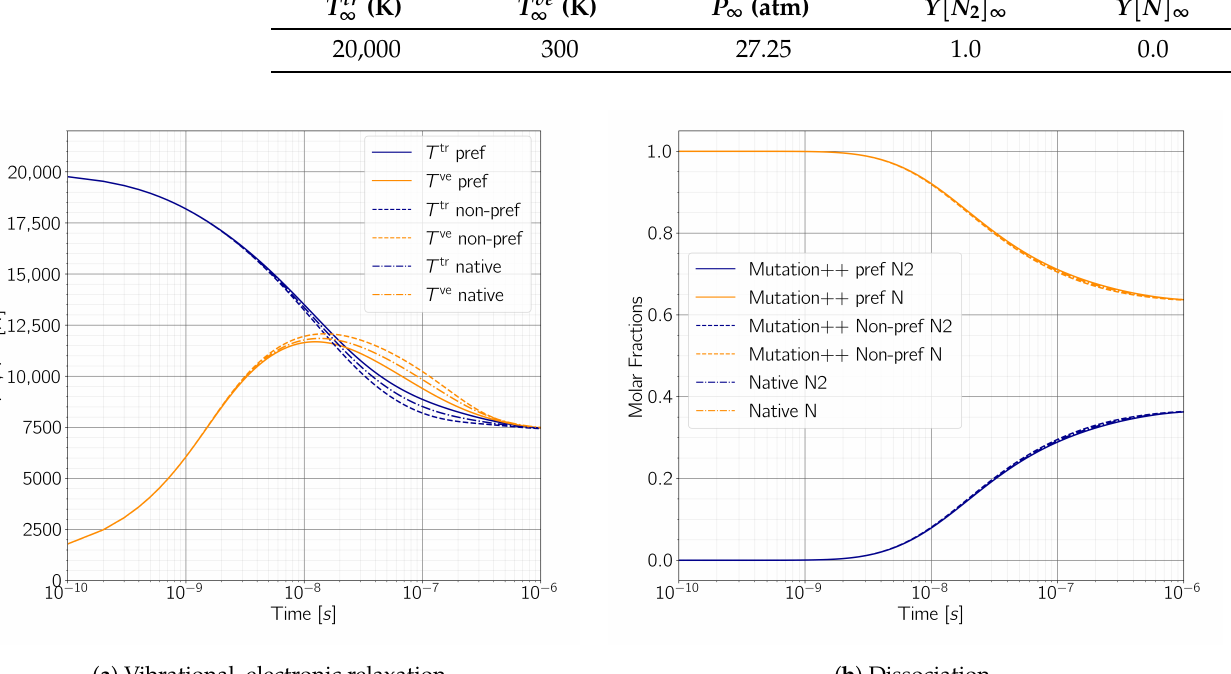
Figure 4. N2 thermal bath thermochemical nonequilibrium